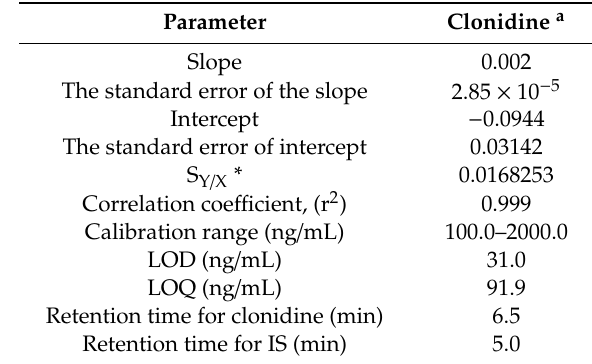
Table 3. Analytical characteristic parameters of the investigated HPLC method. LOD: limit of detection, LOQ: limit of quantification.